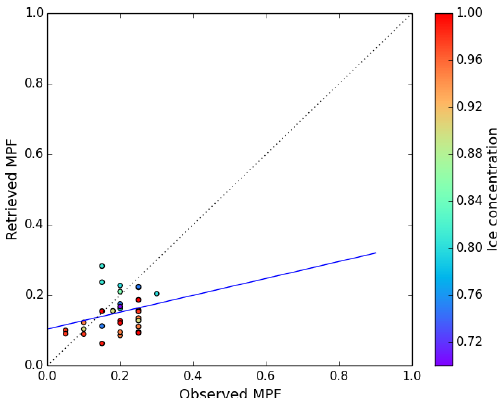
Figure 18. Retrieved MPF vs. observed MPF from the hourly bridge observations during HOTRAX 2005, 19 August–27 Septem- ber 2005. Swath data, no temporal averaging, 15km satellite aver- age around the in situ point. No information on ice type. Corrected for ice concentration. Underestimation may be connected to undoc- umented presence of melted through or frozen over ponds at the end of the melt season. R 2 = 0.067, RMS = 0.084, N =